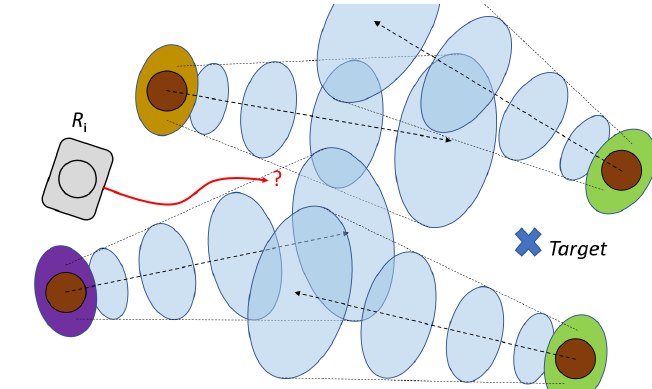
Figure 9. The Freezing Robot Problem (FRP). The robot is R i and the ellipses represent the predictive covariance. It is not easy for the robot to find a route to the